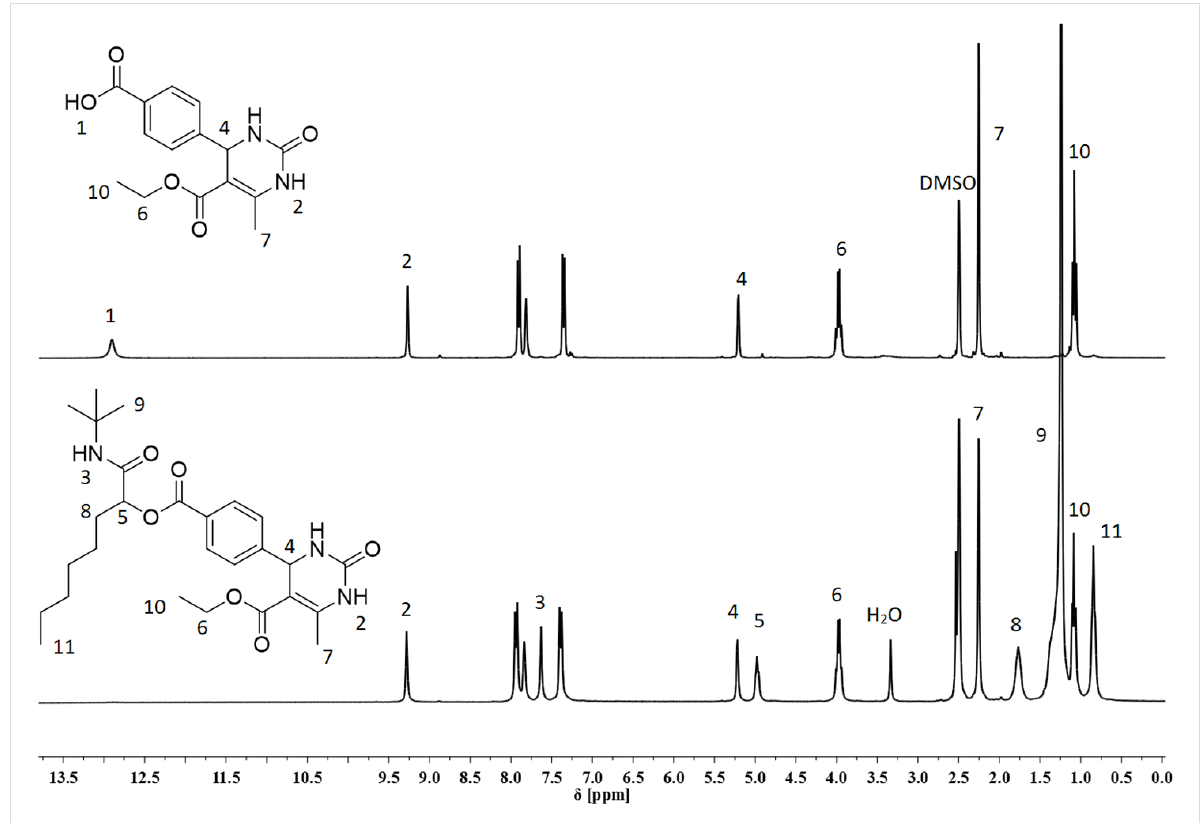
Figure 2: Stacked 1 H NMR spectra and signal assignment. Top: DHMP acid 17 ; bottom: Biginelli–Passerini tandem product 19